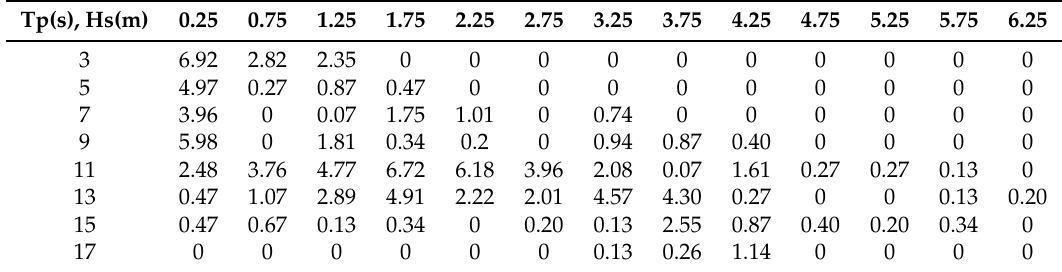
Table 3. Probability density (%) of waves according to significant wave heights and time periods for May 2009 at Orkney.